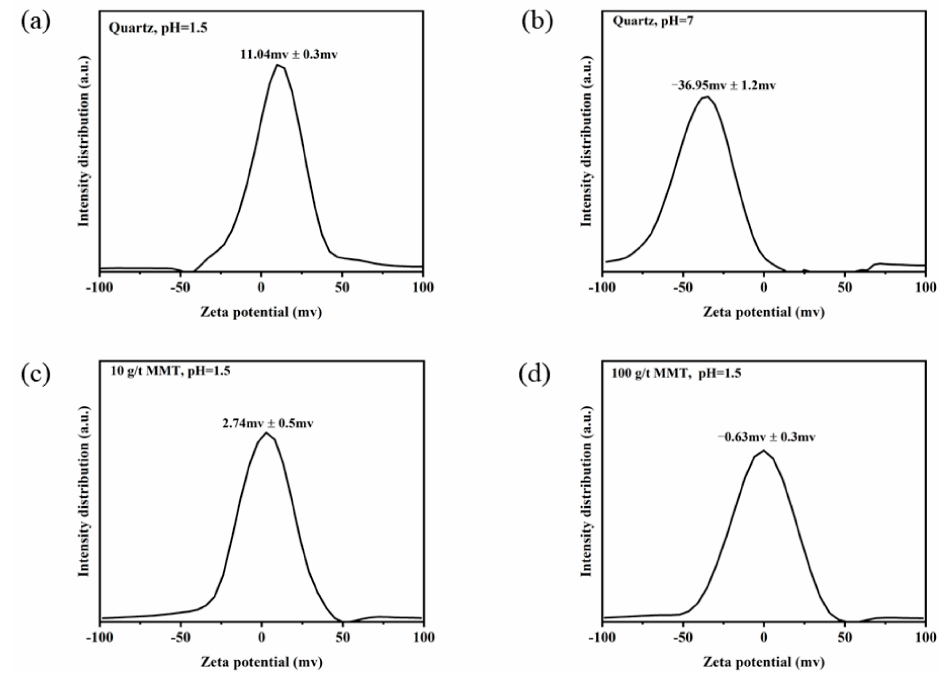
Figure 11. The zeta potential of quartz suspension: ( a ) pH1.5; ( b ) pH7; ( c ) pH1.5 with 10g/t MMT; ( d ) pH1.5 with 100g/t MMT.